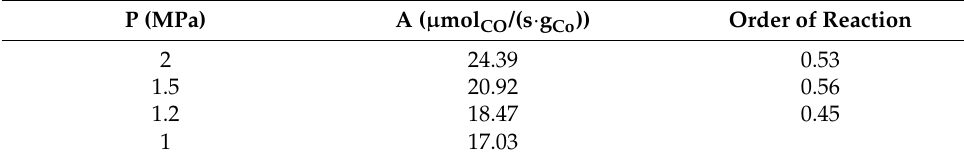
Table 5. Dependence of catalyst activity (A) and reaction order on FTS pressure. P (MPa) A ( µ mol CO /(s · g Co